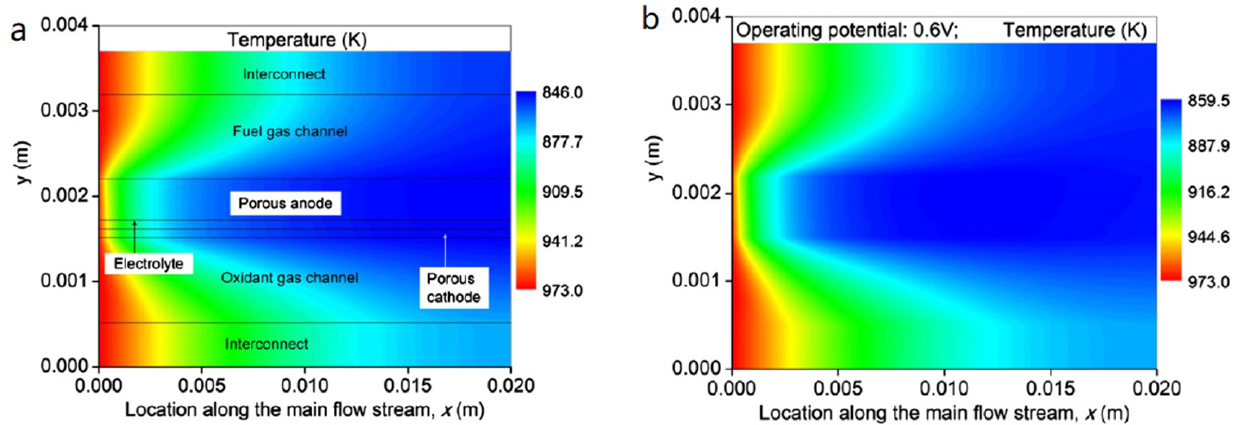
Figure 13. Temperature distribution in SOFC at an inlet temperature of 973 K with an operating potential: ( a ) 0.8 V; ( b ) 0.6 V [46].